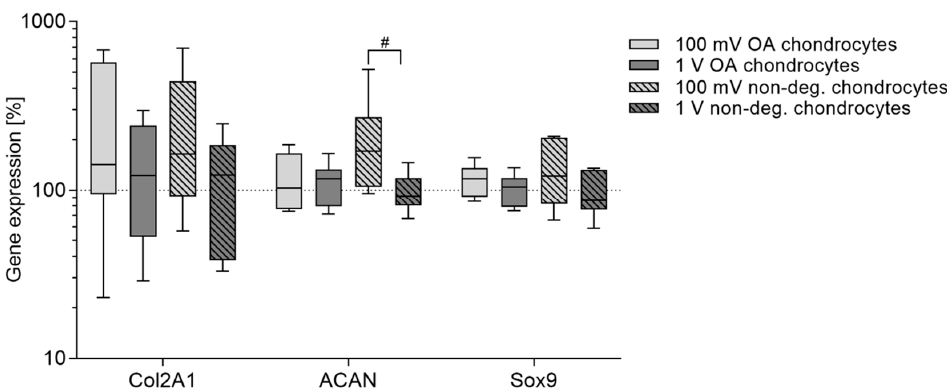
Figure 5. Relative gene expression of chondrogenic differentiation markers in human chondrocytes after electrical stimulation with 100 mV and 1 V at 1 kHz. Chondrocytes derived from non-degenerative ( n = 4) or osteoarthritic (OA) cartilage ( n = 6) were seeded on collagen scaffolds and electrical stimulation was performed over a period of seven days. Afterwards, RNA was isolated to determine the gene expression of chondrogenic differentiation markers via semi-quantitative polymerase chain reaction (qPCR). Data are presented as boxplots of the percentage of 2 ( −ΔΔ Ct) related to unstimulated cells (100%). Statistical analysis within a stimulation group was performed with Friedman test by using the ∆∆ Ct-values ( # p <